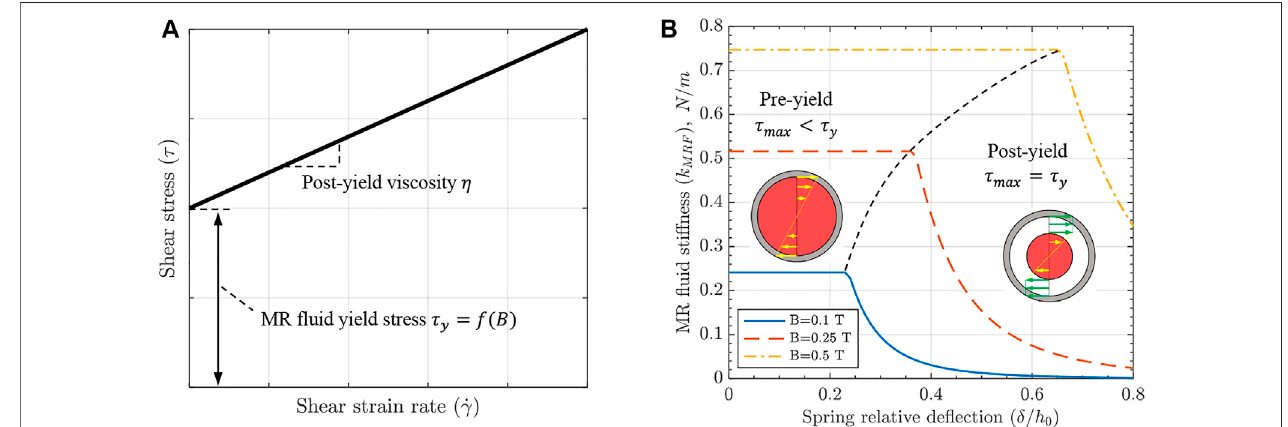
FIGURE 3 | (A) Bingham viscoplastic model utilized for MR fl uid mechanics in the analytical model of the device; (B) MR fl uid stiffness component vs. spring de fl ection at various magnetic fi elds. According to the analytical model ( Eqs 1 – 4 ), two cross-sections of the spring are illustrated for pre- and post-yield regions with shear stress distribution and solid (pre-yield) MR fl uid shown in